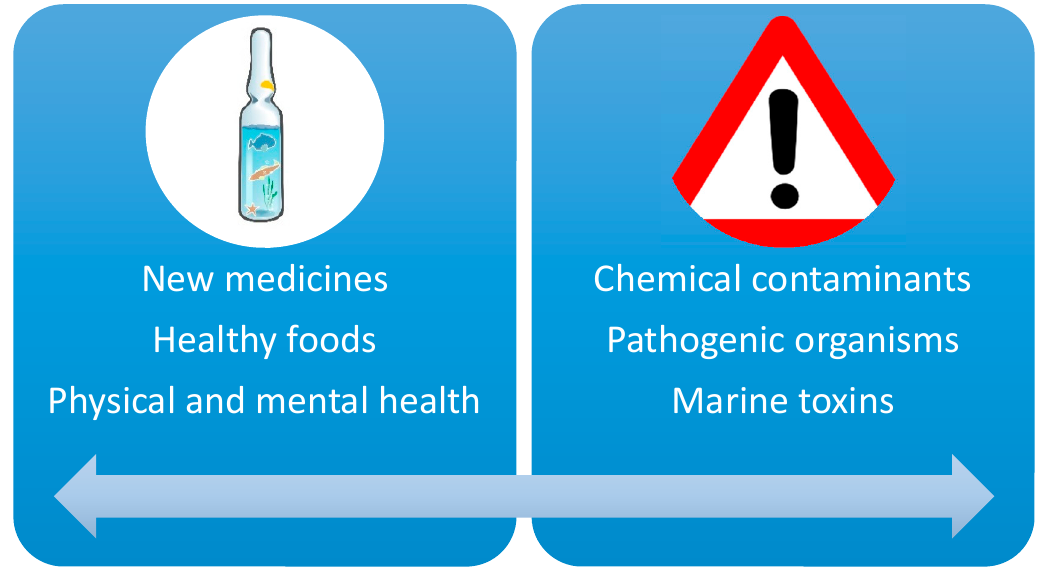
Figure 4. The current and emerging OHH issues identified by the Chair during the implementation phase: health benefits ( left ) and health risks ( right ).